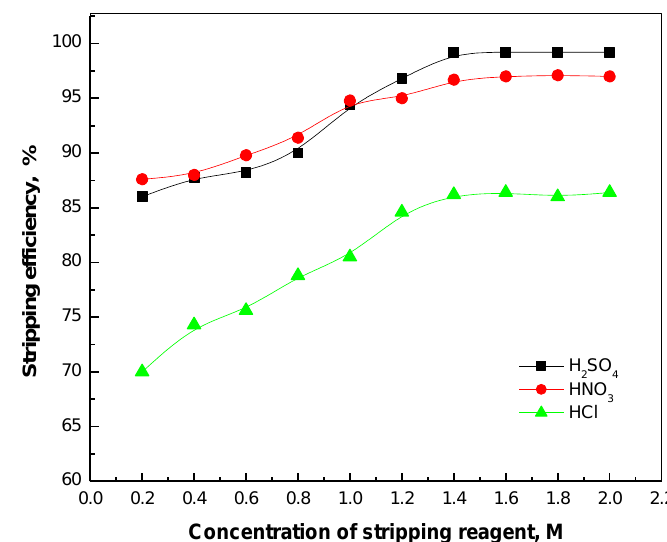
Fig. 8. Effect of reagent concentration on stripping of copper.